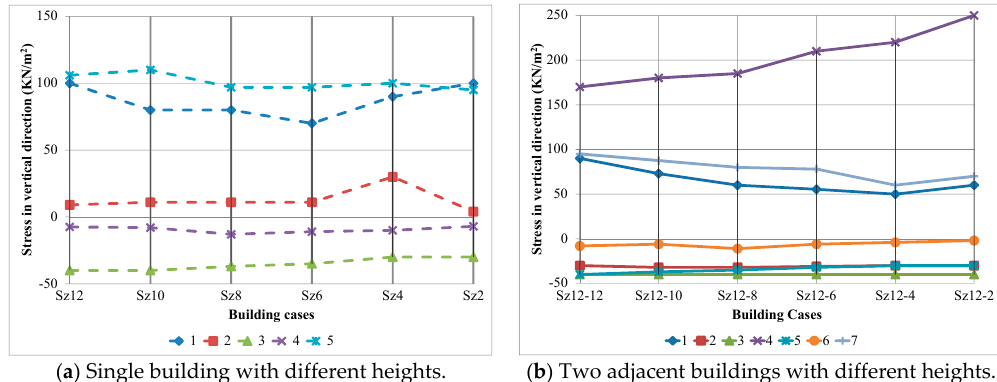
Figure 11. Stress in the soil in z direction around the foundation of the single and adjacent buildings.